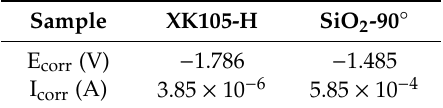
Table 2. Electrochemical properties of heat treated and surface-roughened XK105.